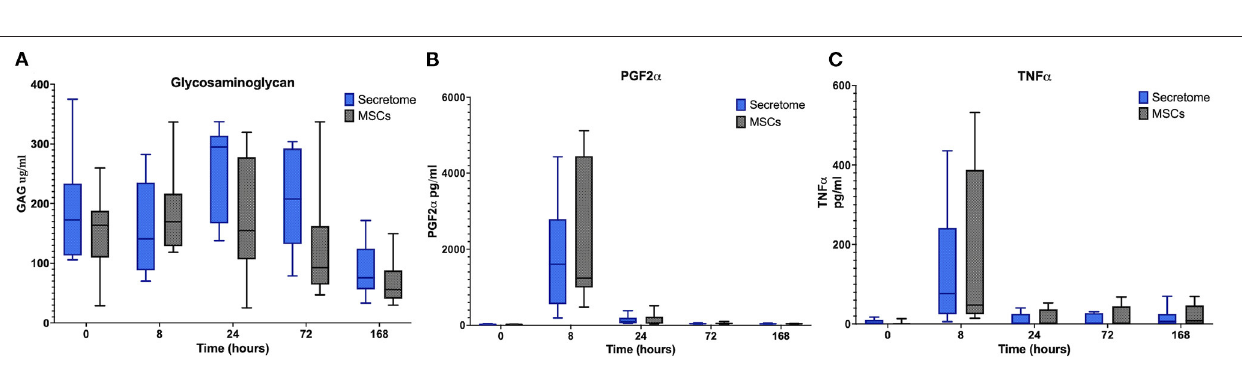
FIGURE 4 | Phase 2 synovial white blood cell counts, total protein and joint circumference. (A) Synovial White Blood Cell Count, (B) Synovial Fluid Total Protein, and (C) Joint Circumference over time following induction of inflammation with intra-articular injection of 0.25 ng of LPS in the left and right radiocarpal joints of horses at PIH 2 0 ( n = 8 horses). Joints were treated with either intra-articular mesenchymal stem cell (MSC)-secretome of mesenchymal stem cells (MSCs) (positive control) at PIH 2 2. Boxes depict median and interquartile ranges; whiskers denote minimum and maximum values. For the Synovial White Blood Cell Count the box and whiskers for the first timepoint are not visible on the graph as the values for these were very low with each measurement recorded is < 1 × 10 9 cells/L.